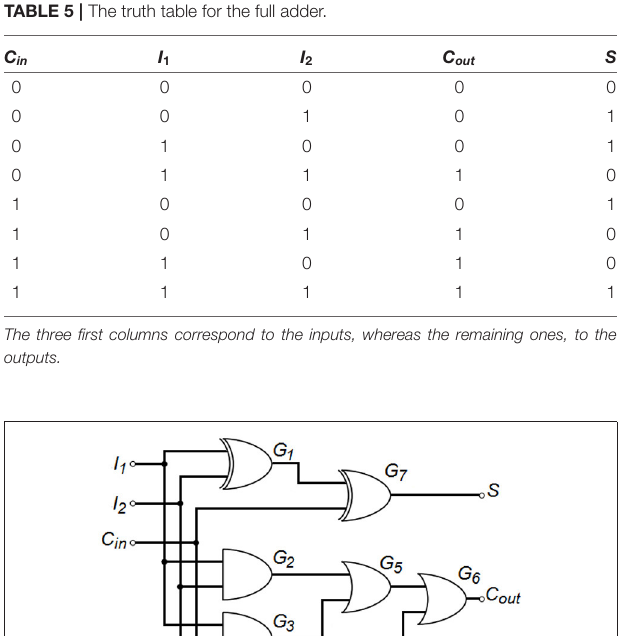
TABLE 5 | The truth table for the full adder.